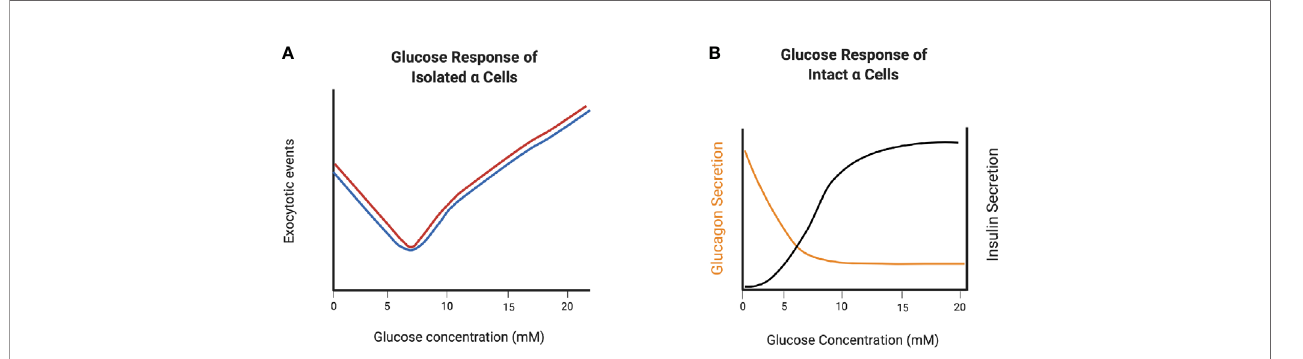
FIGURE 2 | Glucagon secretion from dispersed alpha cells and alpha cells in intact islets demonstrate the role of paracrine regulation at high glucose concentrations. (A) V-shape curve of glucagon exocytosis in response to glucose in dispersed non-diabetic (black) and T2D (red) human a -cells. (B) Glucagon secretion from intact islets in response to glucose. Created with